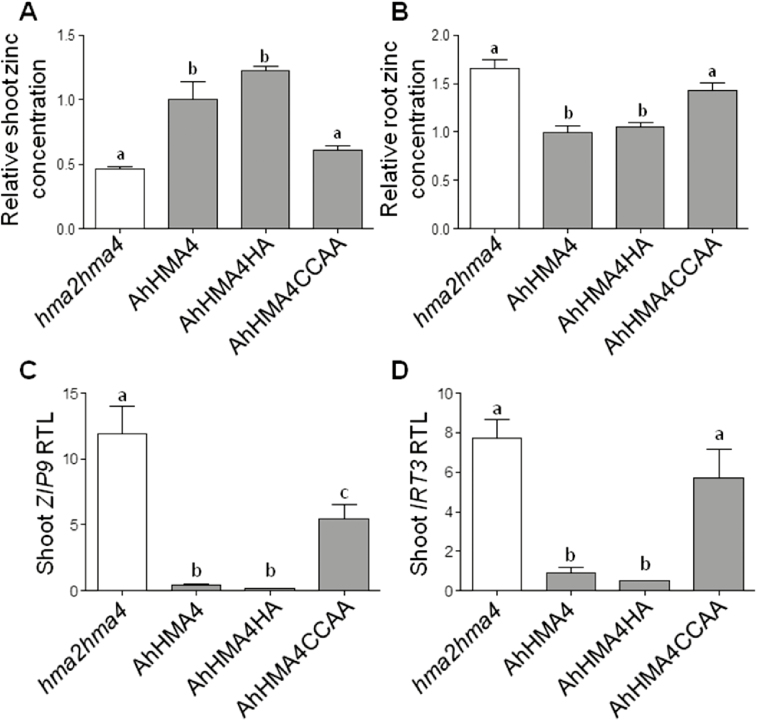
Zinc accumulation and expression of zinc deficiency response genes in complemented plants grown in hydroponic conditions. Non-transformed hma2hma4 mutant (white) and expressing the native or mutant A. halleri HMA4 proteins (medium gray) under the control of AtHMA4 promoter were grown for the last 3 weeks before harvest in Hoagland hydroponic medium containing 0.2 µM zinc. Zinc concentrations were measured in shoot (A) and root (B) tissues collected from two plants per line. Values are relative to lines expressing the native AhHMA4 proteins and are means±SEM of two independent lines from three biological replicates. Transcript levels were quantified from plant tissues collected from two plants per line. Relative transcript levels (RTL) of IRT3 (C) and ZIP9 (D) in shoots are mean±SEM of two independent lines from two biological replicates. The data were analysed with one-way ANOVA followed by Tukey’s multiple comparison test. Statistically significant differences (P<0.05) between means within each figure panel are indicated by different letters. Ah: A. halleri; HA: His-stretch→Ala-stretch; CCAA: di-Cys→di-Ala motifs.